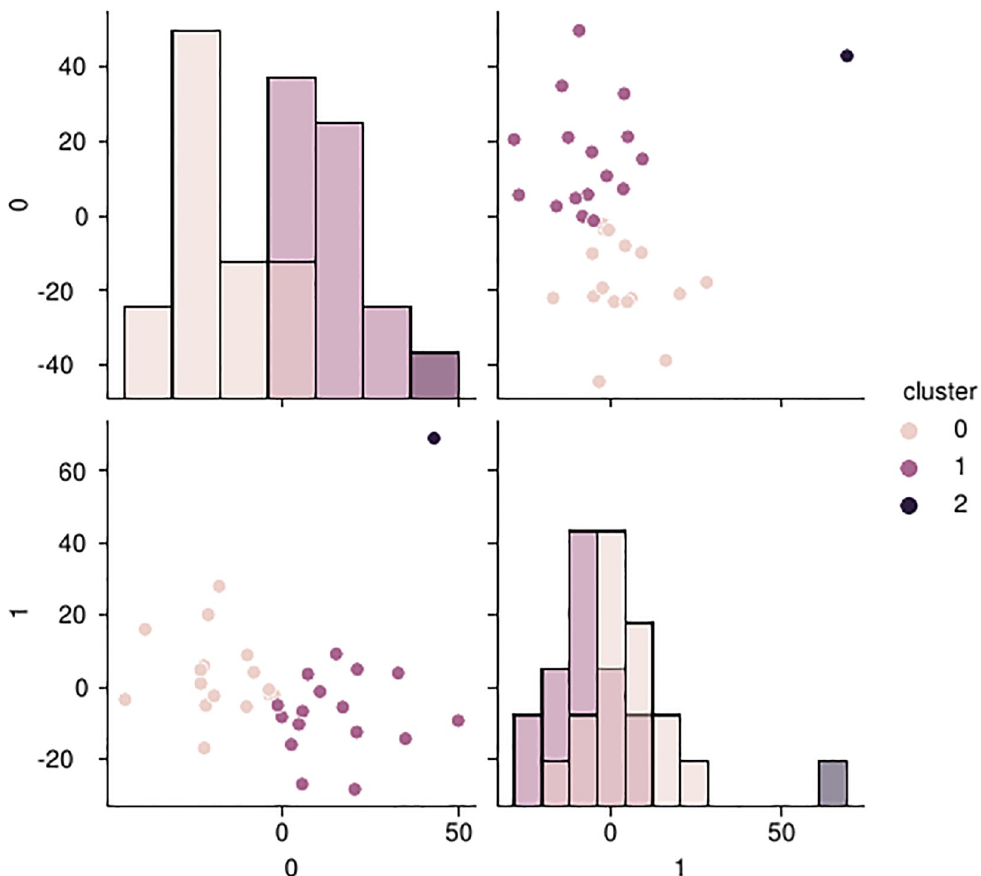
Fig 2. PCA clustering. Pair plot showing the population of COVID-19 diseases in our dataset by their standardized scores reduced from n dimensions (the number of drugs) to two with the help of a PCA. The colors show the affiliation to a cluster derived from the application of a 3-Means